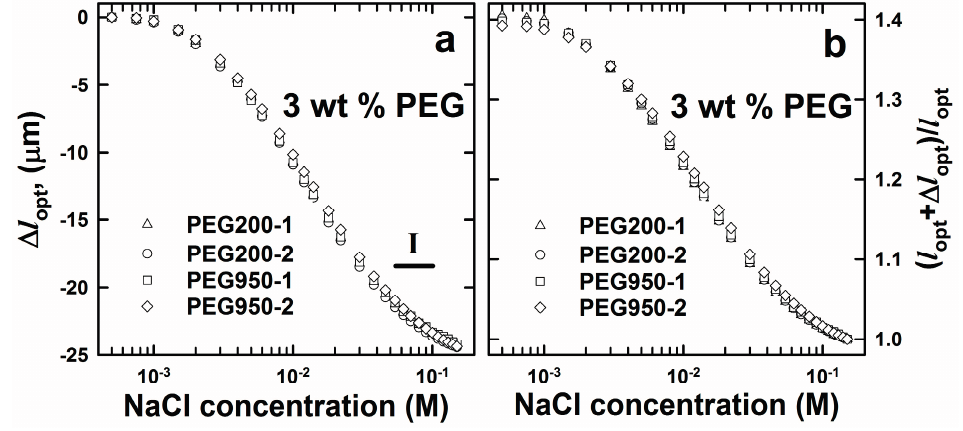
Figure 2. Changes in optical length ( a ) and deswelling ratio ( b ) of (2-acrylamido-2- methylpropane sulfonic acid) -co- acrylamide (AMPSA- co -AAm) hydrogels synthesized in the presence of pore-forming agents. AMPSA porous hydrogels consisted of 10 wt % AAm, 3 mol % Bis (relative to AAm) and 3 mol % AMPSA (relative to AAm) with 3 wt % PEG ( M n = 200 g/mol, PEG200, l opt = 61.7 µm) and PEG ( M n = 950~1050 g/mol, PEG950, l opt = 62.1 µm) removed after synthesis. All measurements were carried out in aqueous salt solution with the NaCl concentration in the range from 5 × 10 − 4 to 0.15 M and at least two times (labeled as -1 and -2 for each experimental series). Region I depicts the NaCl concentration range selected for displaying the time dependence of Δ l opt (Figure 3).